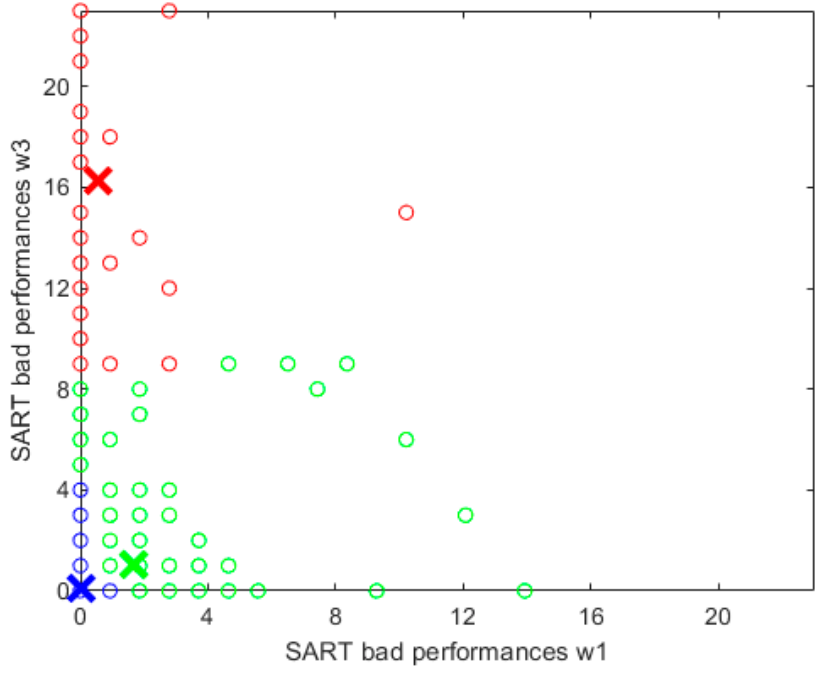
Figure 7. Fuzzy clusters resulted from the FCM algorithm applied to the merged cohort ( N = 3468) considering the values of bad performances at waves 1 and 3. Each cluster is identified by a color.